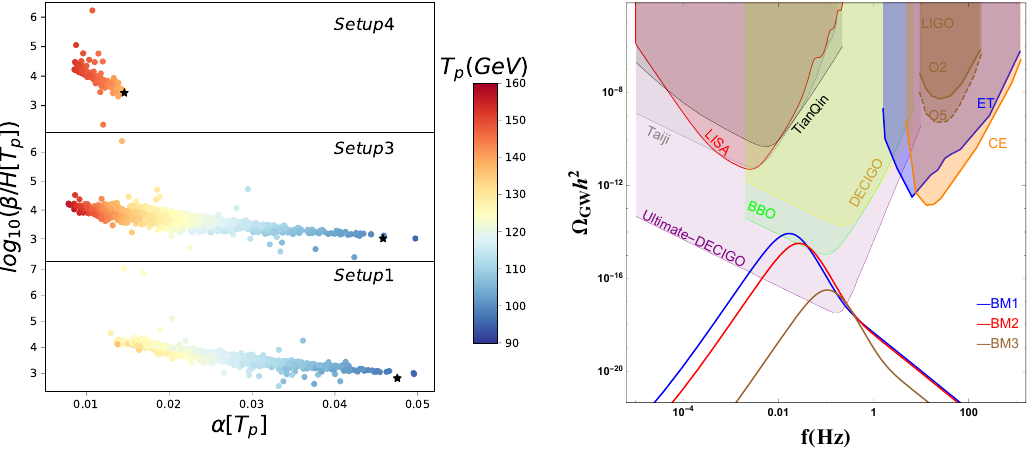
Figure 9 . Left: β/H [ T p ] and α for the four benchmark setups in section 3.5. Note that setup 2 is missing due to the decoupling of the triplet. The legend along with the figure is used to indicate the percolation temperature T , and the black stars denote three benchmark points in table 2. Right: p the representative GW signal spectrum for the three benchmark points in table 2. See the main text for